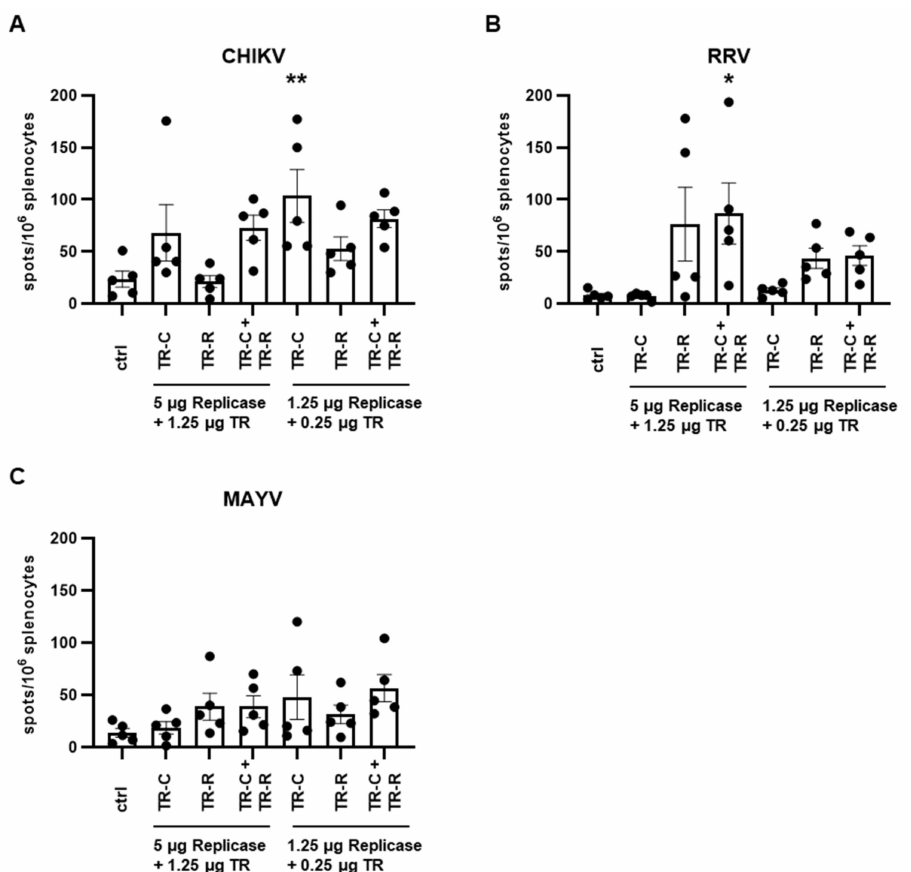
Figure 7. T cell responses after taRNA vaccination. Mouse splenocytes were isolated on day 56 and re-stimulated with ( A ): CHIKV, ( B ): RRV, and ( C ): MAYV and IFN- γ -secreting T cells were then quantified by ELISpot. The mean values ± SEM of each group ( n = 5) are depicted. For statistical analysis, a one-way ANOVA with Dunnett’s multiple comparison post-test was performed (* p < 0.05; ** p <